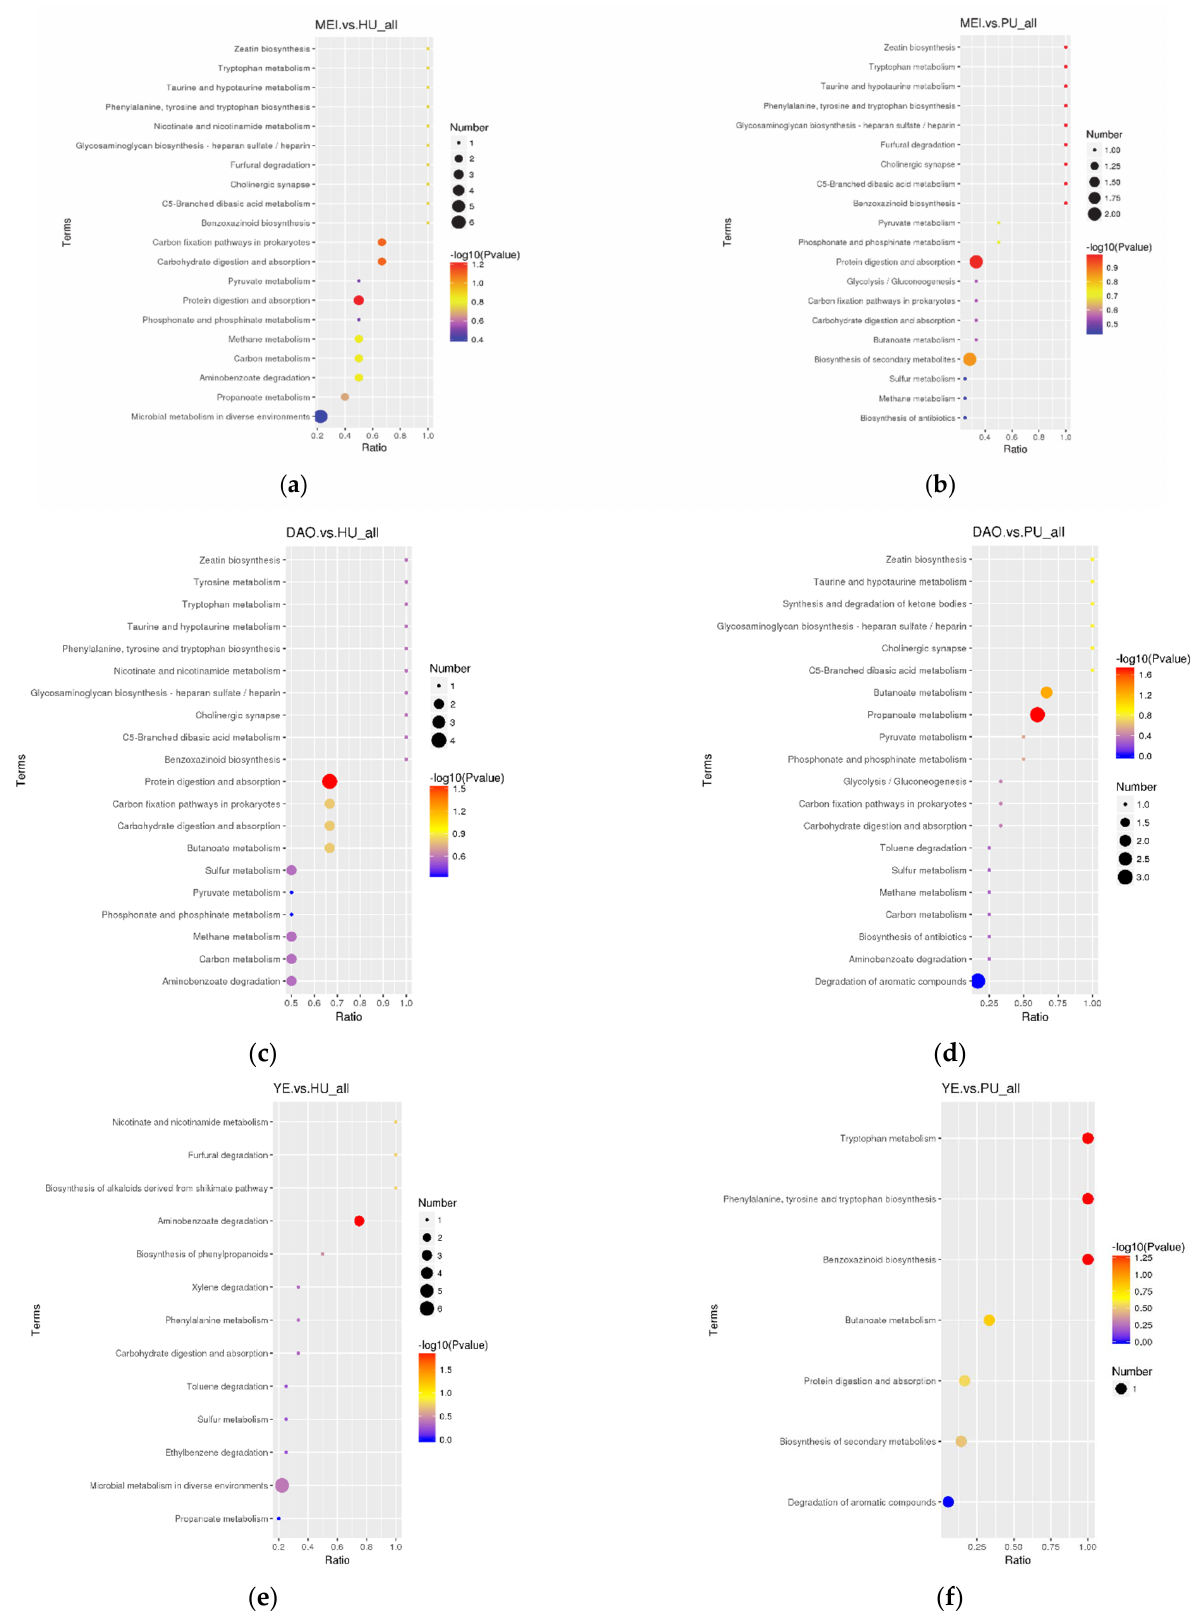
Figure 4. ( a ) The KEGG pathway that the significant differential metabolites take part in Meixiangzhan 2 vs. Huanghuazhan. ( b ) The KEGG pathway that the significant differential metabolites take part in Meixiangzhan 2 vs. Yanfeng 47. ( c ) The KEGG pathway that the significant differential metabolites take part in Daohuaxiang 2 vs. Huanghuazhan. ( d ) The KEGG pathway that the significant differential metabolites take part in Daohuaxiang 2 vs. Yanfeng 47. ( e ) The KEGG pathway that the significant differential metabolites take part in Yexiangyoulisi vs. Huanghuazhan. ( f ) The KEGG path- way that the significant differential metabolites take part in Yexiangyoulisi vs. Yanfeng 47. In these figures, the abscissa is x/y (i.e., the number of differential metabolites in the corresponding metabolic pathway divided by the total number of identified metabolites in the pathway). The higher the value on the abscissa, the higher the degree of differential metabolite enrichment in the corresponding pathway. Dot color represents the p -value of the hypergeometric test; smaller values reflect increased test reliability and greater statistical significance. The size of the dot represents the number of differential metabolites in the corresponding pathway; larger numbers indicate that more differential metabolites were identified in the corresponding pathway. 2.2.1. Variation in Metabolic VOCs among Aromatic Rice Varieties The results showed that the three aromatic rice varieties differed greatly (Figures 2a– c), that is, 10 metabolites distinguished Meixiangzhan 2 from the other varieties: (2- methyloctyl)benzene, 2,2-dichloroethanol, indole, 2,4,6-trimethylpyridine, 2-(octyloxy) ethanol, succinic acid but-3-yn-2-yl 2-methylpent-3-yl ester, 2-ethylheptanoic acid, 3-bu- tene-1,2-diol, dibutoxymethane and 2-octen-1-ol (Table 2). Similarly, 11 differential me- tabolites were identified between Daohuaxiang 2 and other two aromatic rice varieties: butyl benzoate, DL -2-phenyl-1,2-propanediol, 2-acetyl-1-pyrroline, 1,3-dichloro-2-methyl